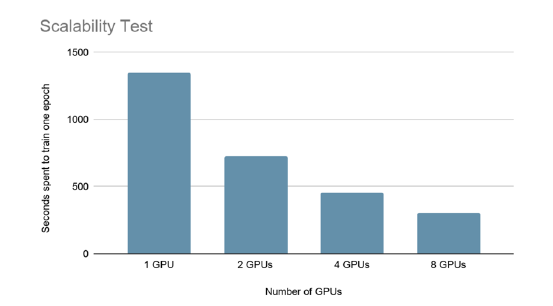
Table 2. Model architecture used in this study. All convolutional layers used same padding Figure 3. Scaling end-to-end deep learning training on multiple GPUs.